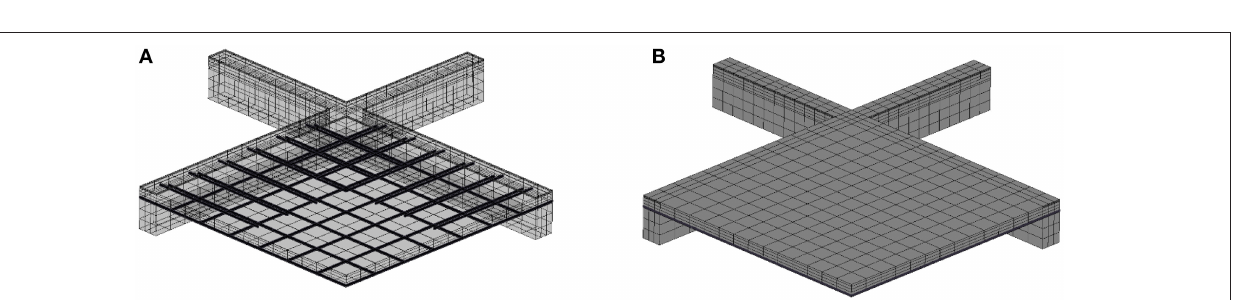
ratio ν 0.25. In the analyses of these models, only clamped = supports were considered, yielding negative moments at the edges and positive moments at the center; simple support slabs were not analyzed because this condition provides only positive moments, which needs only steel reinforcement at the bottom of the slab.